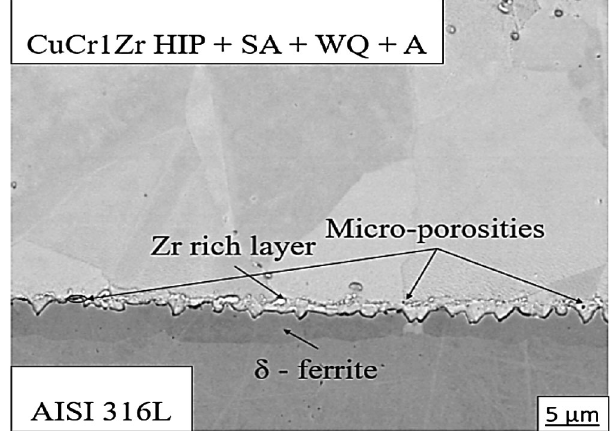
FIG. 7. SEM image at 3000 × and 15 kV accelerating voltage. A continuous δ -ferrite layer is visible on the SS side, whereas microporosities due to the Kirkendall effects and Zr inclusions (observed also in Ref. [10]) are distinguish- able on the CuCr1Zr side.